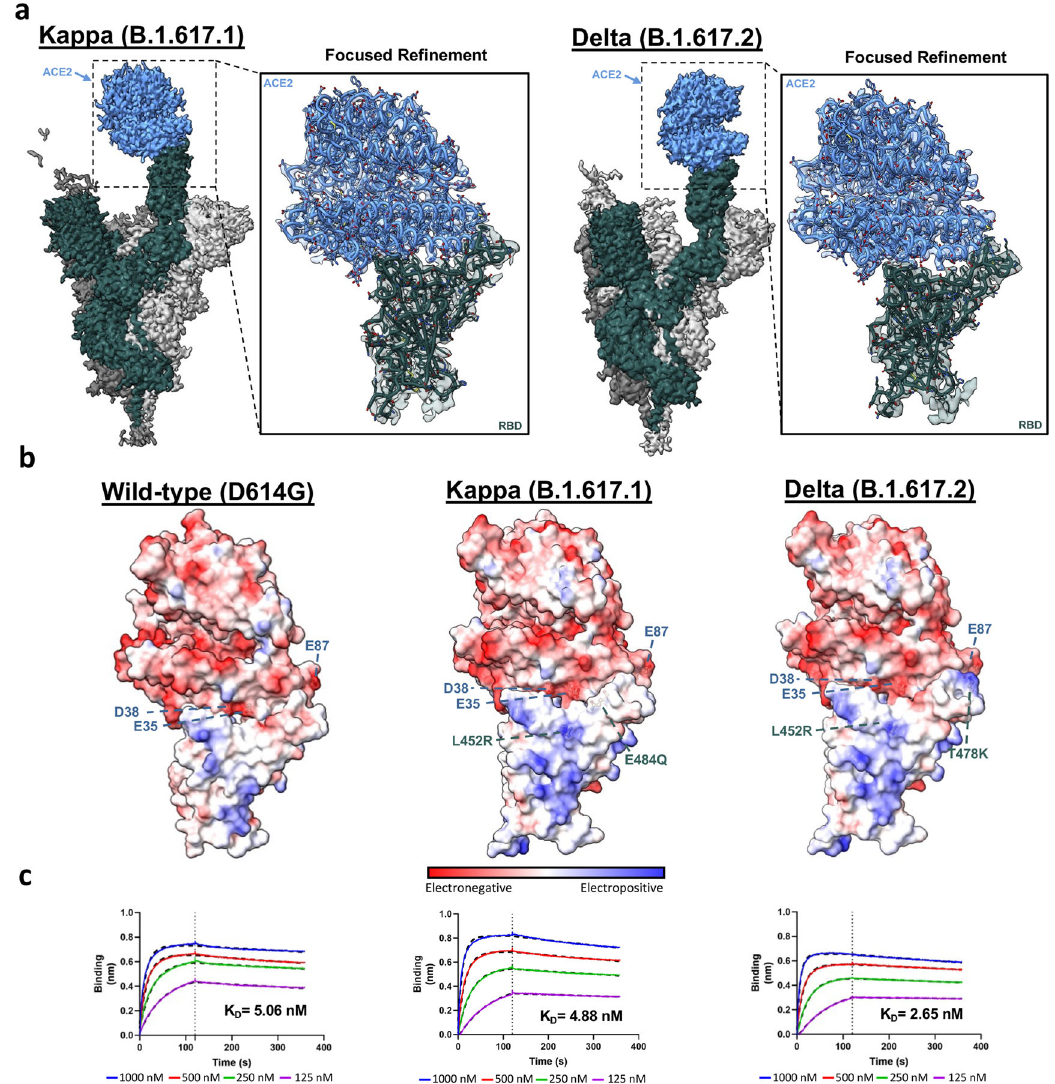
Fig. 3 Structural and biophysical effects of Kappa and Delta S protein mutations on ACE2 binding. a The global and focus-re fi ned cryo-EM structures for the Kappa and Delta variant S proteins in complex with ACE2. A more focused view to show the quality of the cryo-EM density at the S protein – ACE2 interface is provided in Supplementary Fig. 6. b Electrostatic surface potentials for the wild-type, Kappa and Delta S protein – ACE2 complexes. Electrostatic potential colouring spans − 10 kcal mol − 1 e − 1 (darkest red) to 10 kcal mol − 1 e − 1 (darkest blue). We previously reported the structure of the wild-type S protein – ACE2 complex and we use this model here to generate the wild-type electrostatic surface 23 . c Biolayer interferometry (BLI) sensorgrams for the wild-type, Kappa, and Delta variant S protein – ACE2 binding interaction. The S protein concentrations utilised are: 1000 nM (blue), 500 nM (red), 250 nM (green), 125 nM (magenta). The k on and k off rate constants are presented in Supplementary Fig. 3. Source data are provided as a Source Data fi